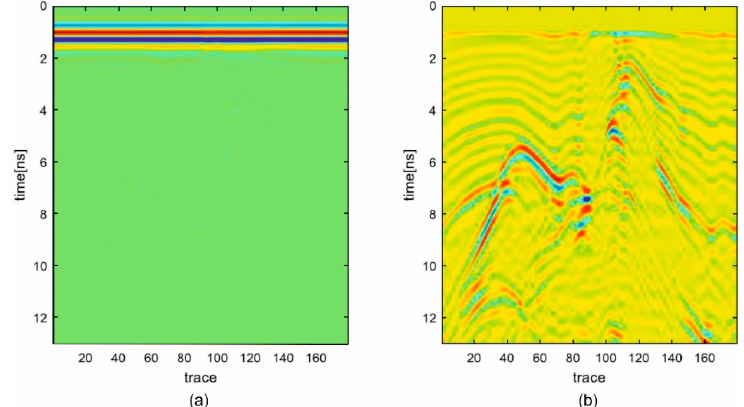
Figure 12. Radargrams of the simulations for the complex-shaped hardwood tree scenario. ( a ) Raw radargam; ( b ) processed radargram after the application of the pre-processing stage.